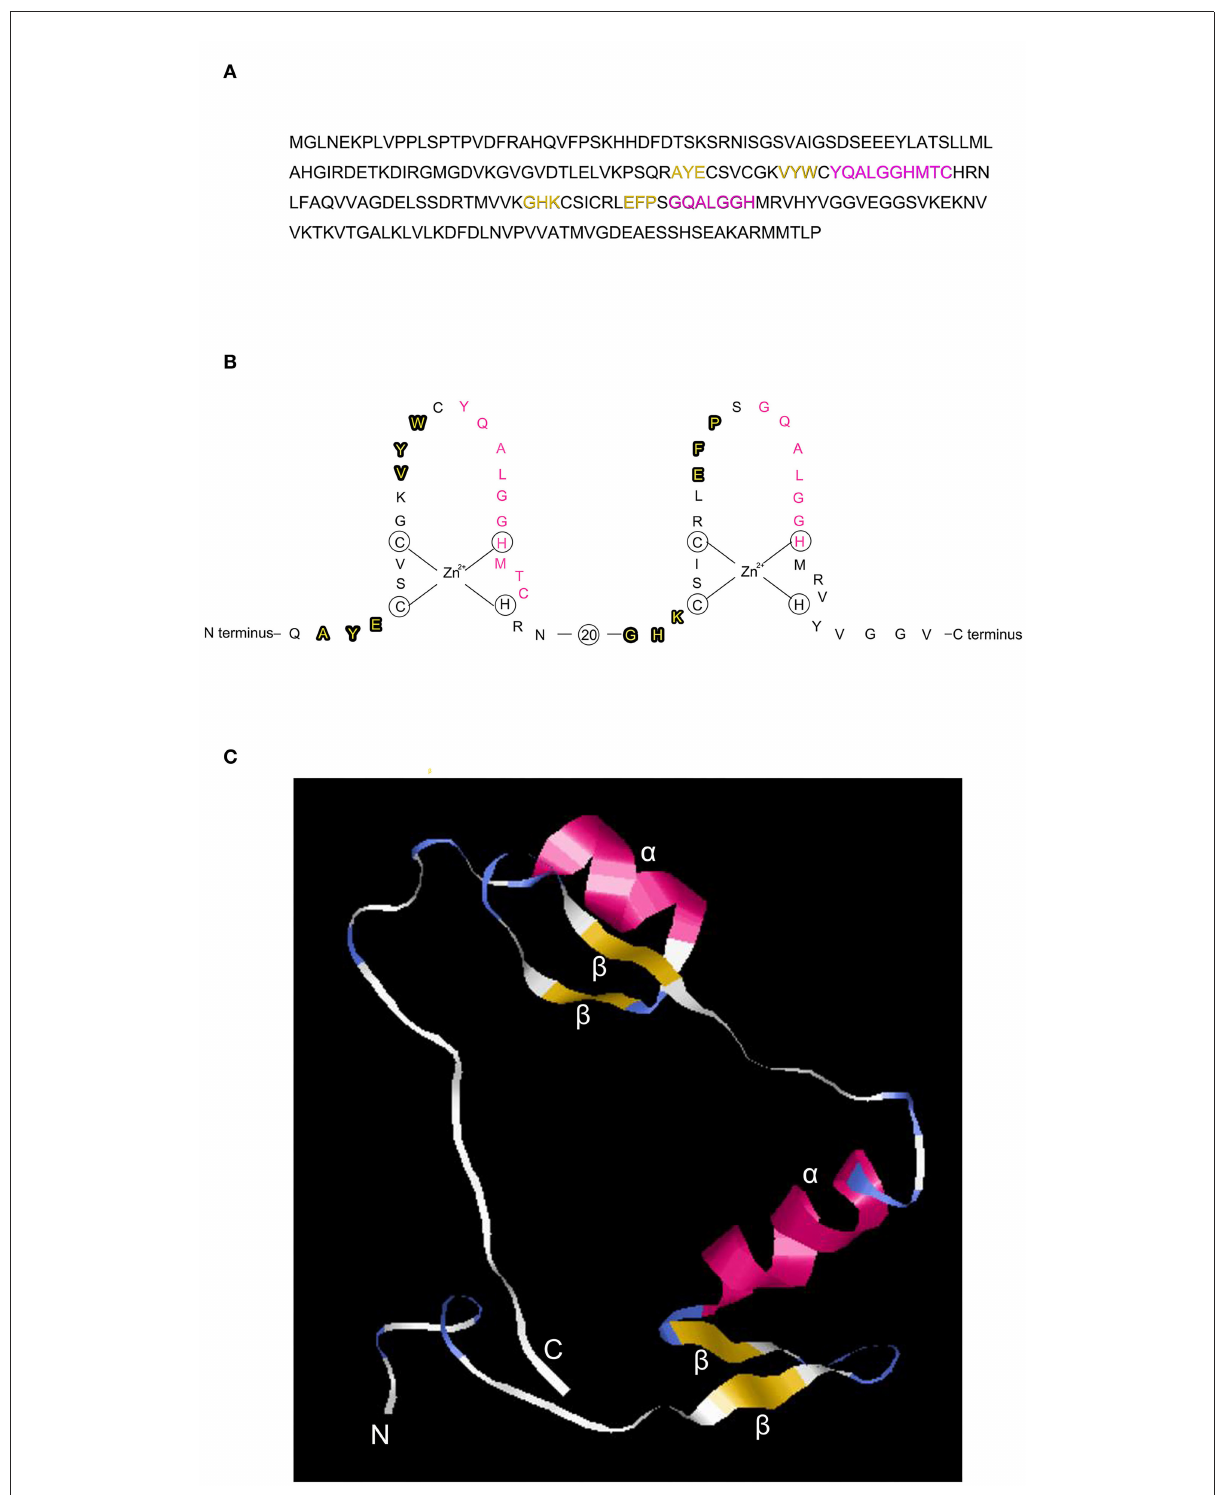
FIGURE1 Structure of the C2H2-type zinc finger transcription factor ZFP39. (A) Amino acid sequence of the zinc finger protein ZFP39 (GenBank: AAQ95583.1) containing two tandem fingers, each finger has two β strands (in yellow) and one α helix (in pink). (B) Structure of the two tandem zinc finger motifs, 20 indicates 20 amino acid residues omitted between the two fingers for conciseness. The β strand and α helix of the zinc finger protein are highlighted in bold and pink, respectively. (C) 3D structure of the two tandem zinc fingers demonstrated using phyre2 (Protein Homology/analogY Recognition Engine V 2.0) (http://www.sbg.bio.ic.ac.uk/phyre2/html/page.cgi?id=index) and shown by the RasMol software (http://www.rasmol.org). N and C indicate the N terminal and C terminal, respectively. β , β strand. α , α